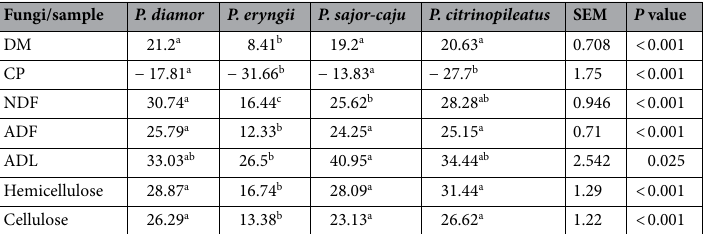
Table 2. Loss of nutrients (%) from corn stover after 21 days of incubation with various white rot fungi ( Pleurotus sp .) or control. SEM: standard error of mean. a–b Within a row, means without a common superscript differed ( P <